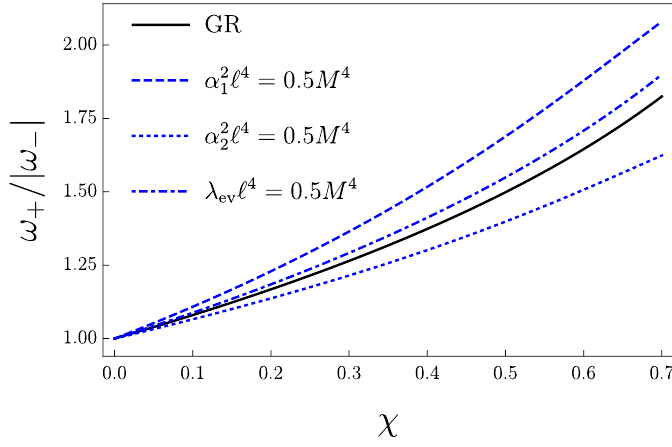
Figure 9 . Ratio of light ring frequencies ! + = j ! (cid:0) j in several